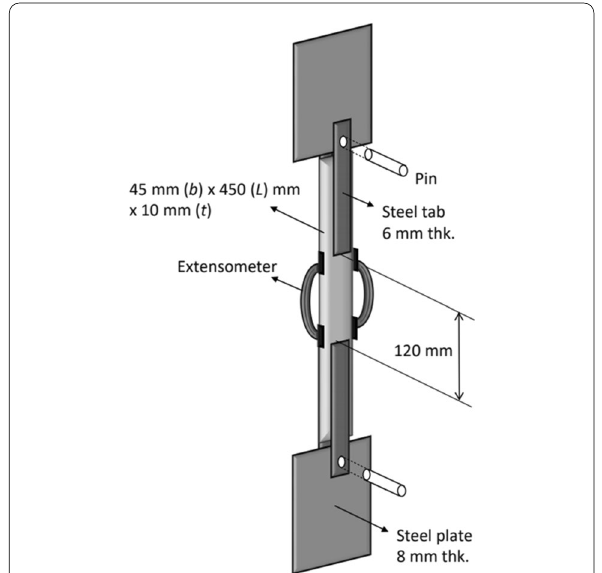
Fig. 3 Tensile test setup.